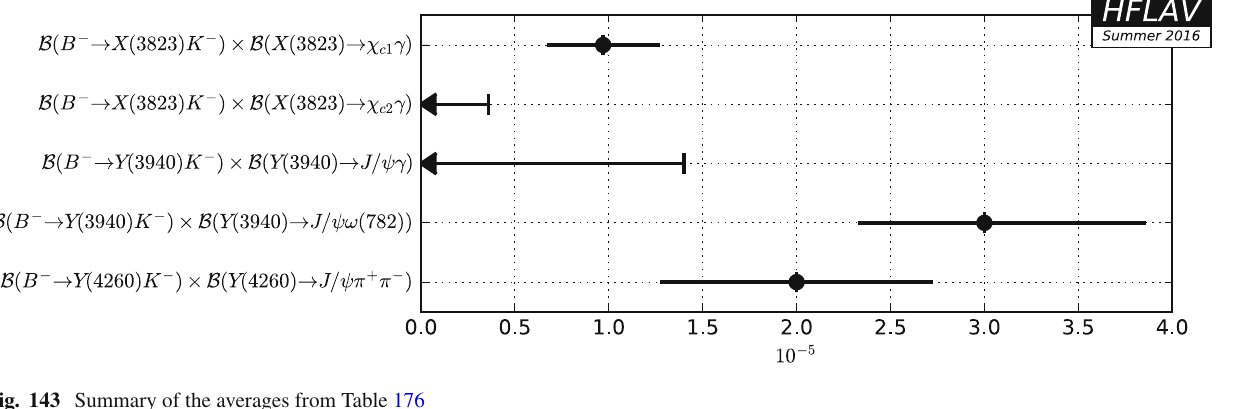
Fig. 143 Summary of the averages from Table 176